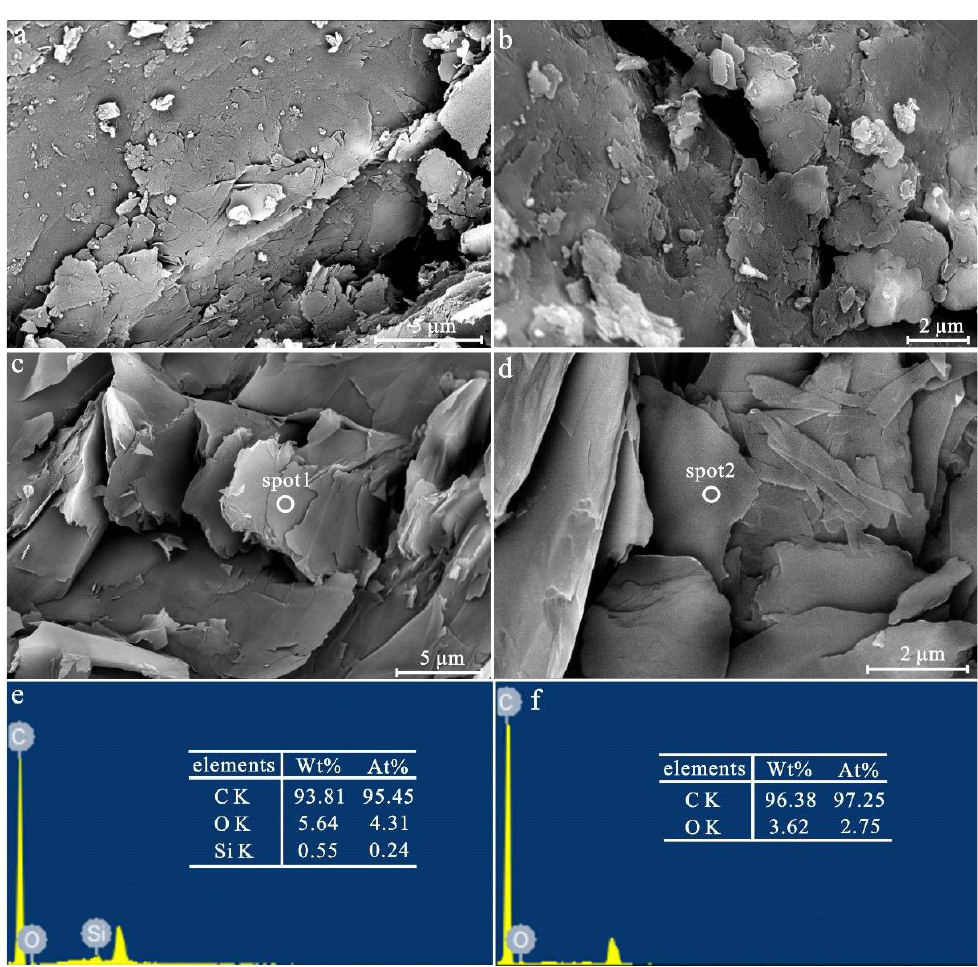
Figure 5. SEM images of graphite microcrystals in graphitized coal samples. ( a ) Flake-like graphite microcrystals in sample CO1; ( b ) enlargement of rectangle in ( a ); ( c ) irregular flake graphite micro- crystals in sample CO3; ( d ) flake-like graphite microcrystals in sample QK; ( e ) EDS spectrum of point in ( c ); ( f ) EDS spectrum of point in ( d ).